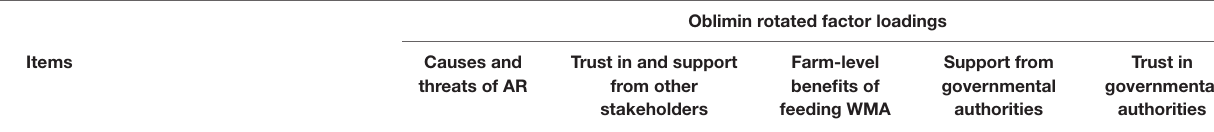
TABLE 4 | Summary of the exploratory factor analysis results for the questionnaire on perceptions related to the feeding of waste milk containing antibiotic residues (WMA) to calves and antibiotic resistance (AR), using responses from 227 dairy producers.